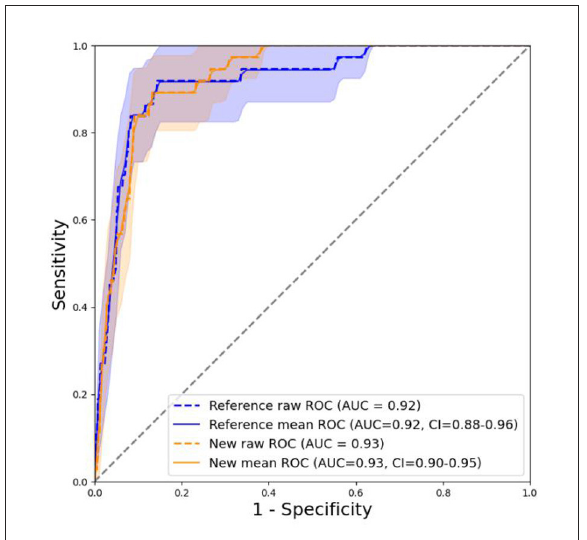
FIGURE7 ROC curve, in which the new model refers to SVM and the old one refers to LR.